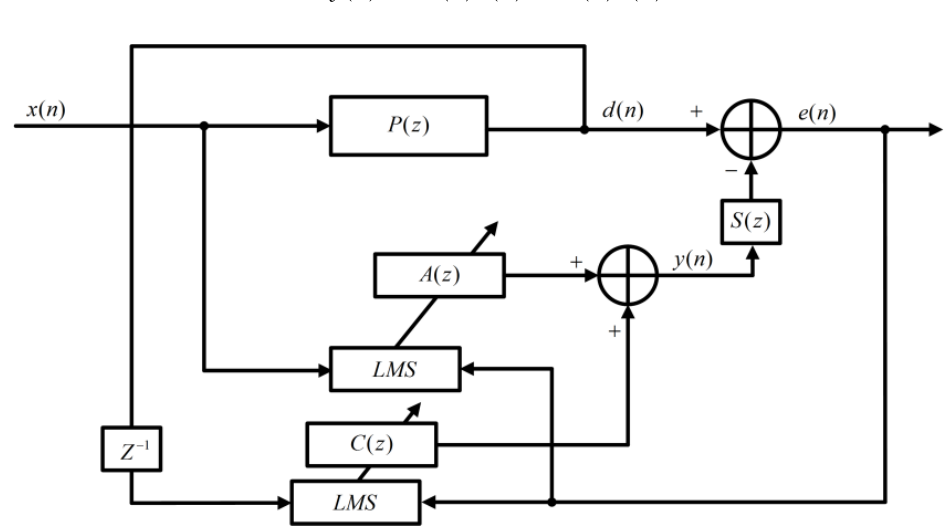
Figure 2. ANC system based on an equation error (EE) adaptive infinite-impulse-response (IIR) filter. The complete ANC system block diagram based on the EE model is shown in Figure 3.